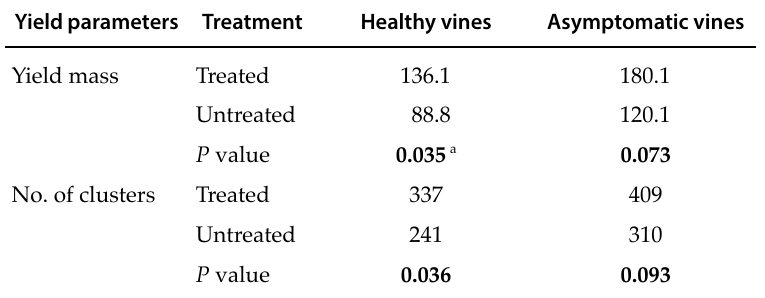
Table 5. Grape yield in the cv. Trebbiano d'Abruzzo vineyard in 2012 following treatment in healthy and asymptomatic vines.